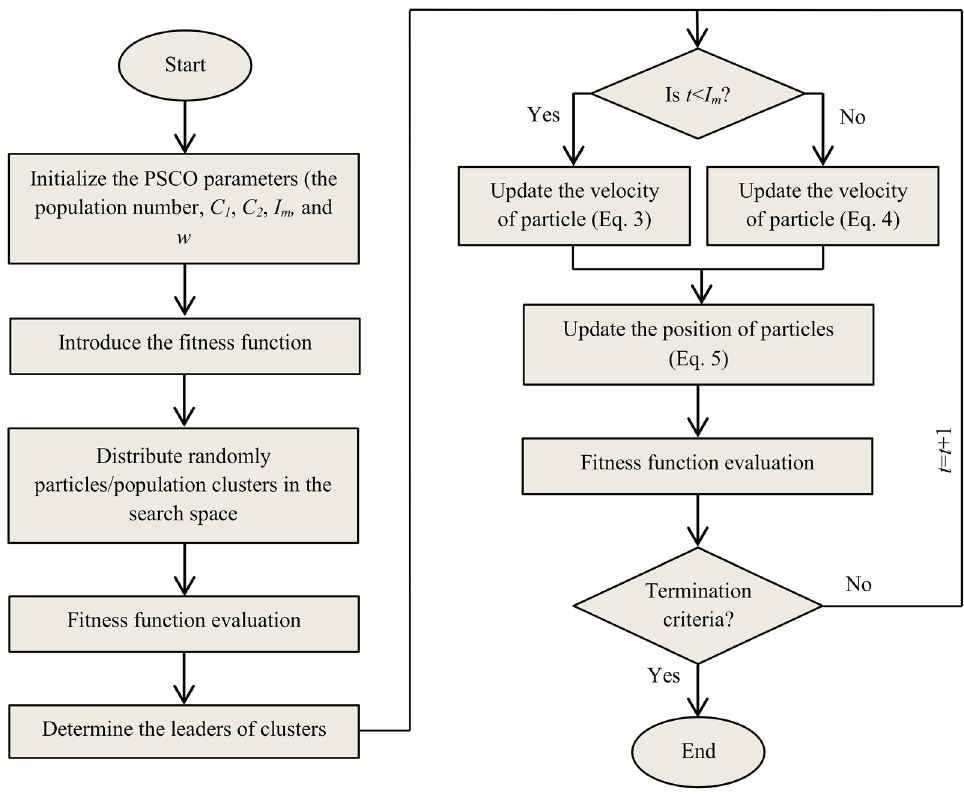
Fig. 1 The flowchart of PSCO